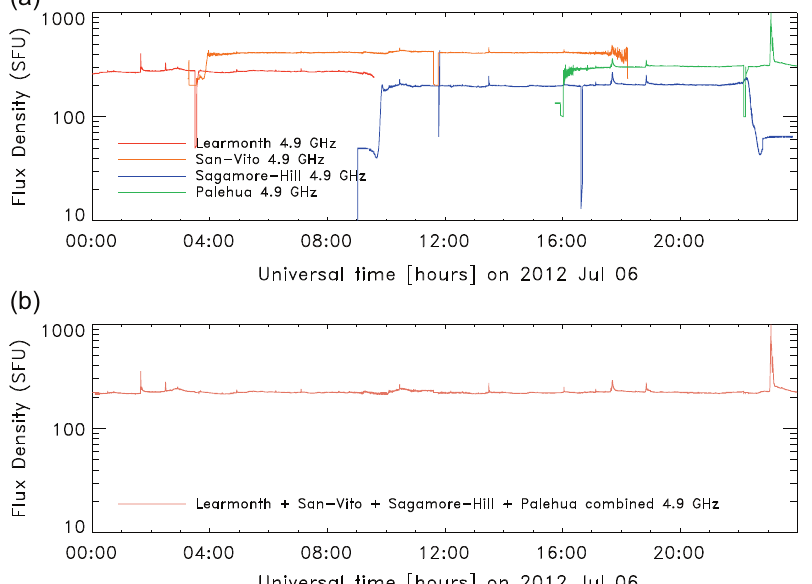
Fig. 3. Example of microwave data for a sample 24-hr interval. (a) The flux density observed by the four RSTN stations at 4.9 GHz. Spikes, discontinuities and background are corrected in the combined flux density